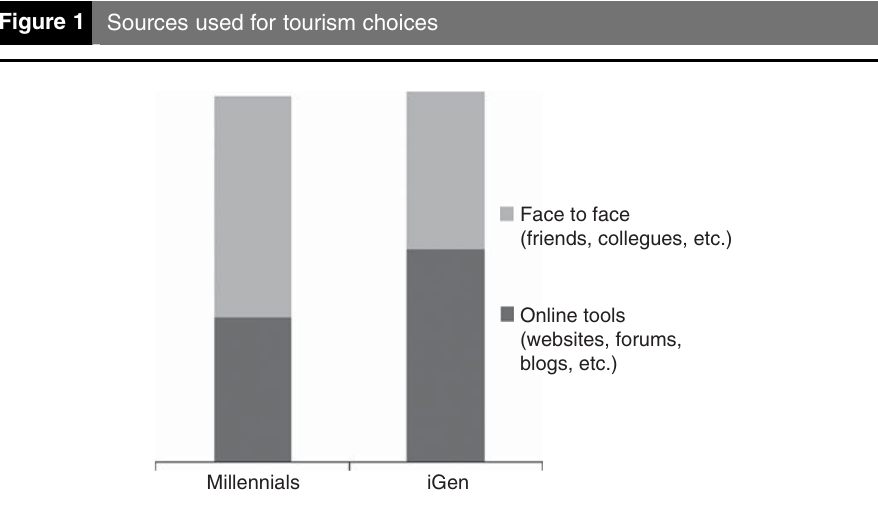
Figure 1 Sources used for tourism choices